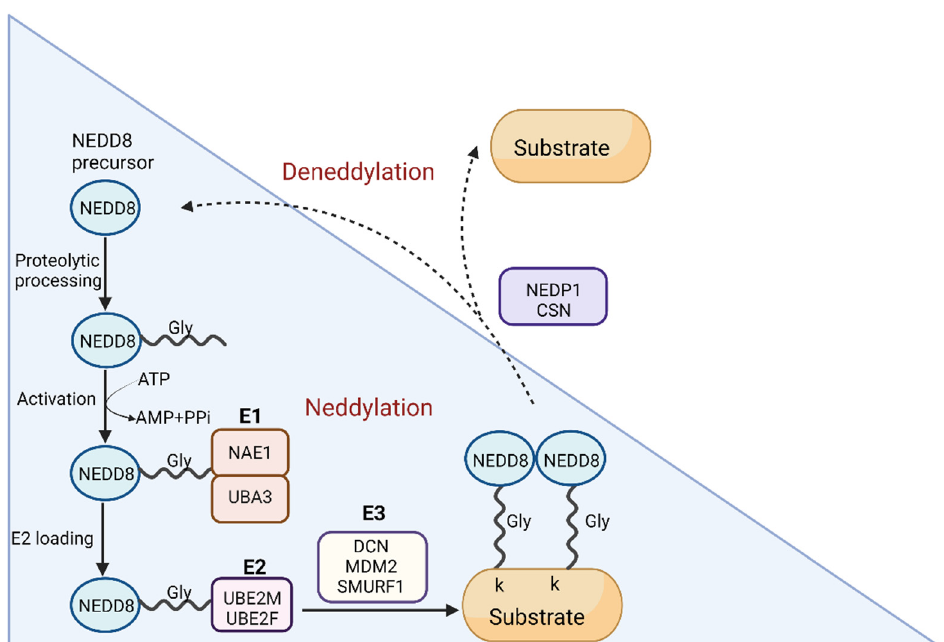
Figure 1. Proteolytic processing of precursor NEDD8 by DEN1/NEDP1 enzyme exposes C-terminal glycine (Gly76). Activation of mature NEDD8 occurs through ATP-dependent thioester linkage of Gly76 with cysteine at its active site and catalyzed by NAE, a heterodimer of UBA3 and NAE1 (APP-BP1). The active cysteine site of NAE then transfers activated NEDD8 to either E2 UBE2M or UBE2F’s active cysteine site. The C-terminal glycine of NEDD8 is exposed to nucleophilic assault by the substrate’s lysine residue due to E2 (cid:48) s interaction with an E3 ligase. This results in the covalent attachment of NEDD8 to the target proteins through an isopeptide bond. To remove NEDD8 moieties from substrates, the deneddylases NEDP1 and CSN catalyze the process. The Blue shaded region indicates neddylation. Abbreviations: APP-BP1—APP binding pro-tein 1; CSN—COP9 signalosome; DEN1—Human deneddylase 1; NEDD8—neural precursor cell expressed developmentally downreg- ulated protein 8; NEDP1—NEDD8-specific protease; NAE—NEDD8-specific E1 activating enzyme; Uba3—NEDD8-activating enzyme E1 catalytic subunit. Image created in Biorender.com, accessed on 19 September